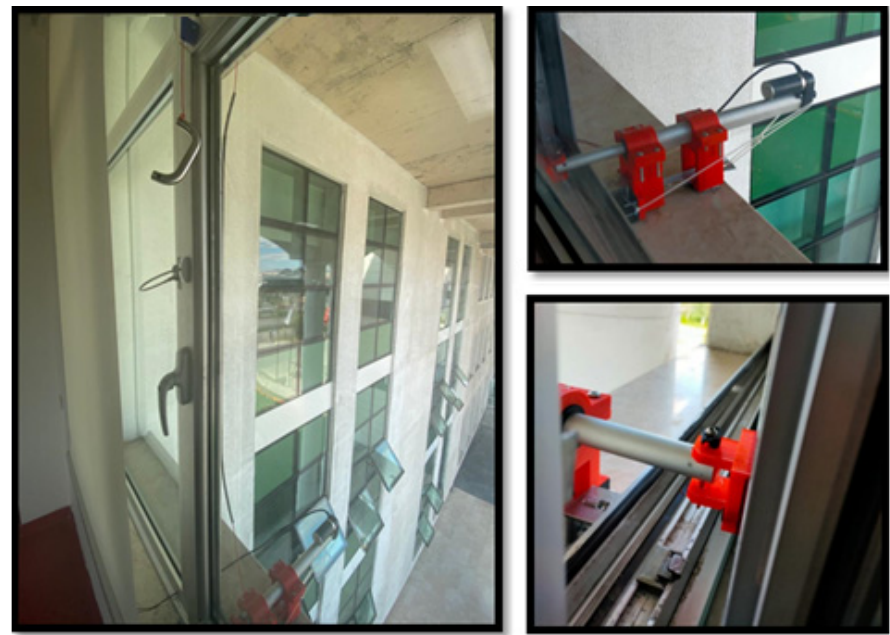
Figure 7. Natural ventilation system .